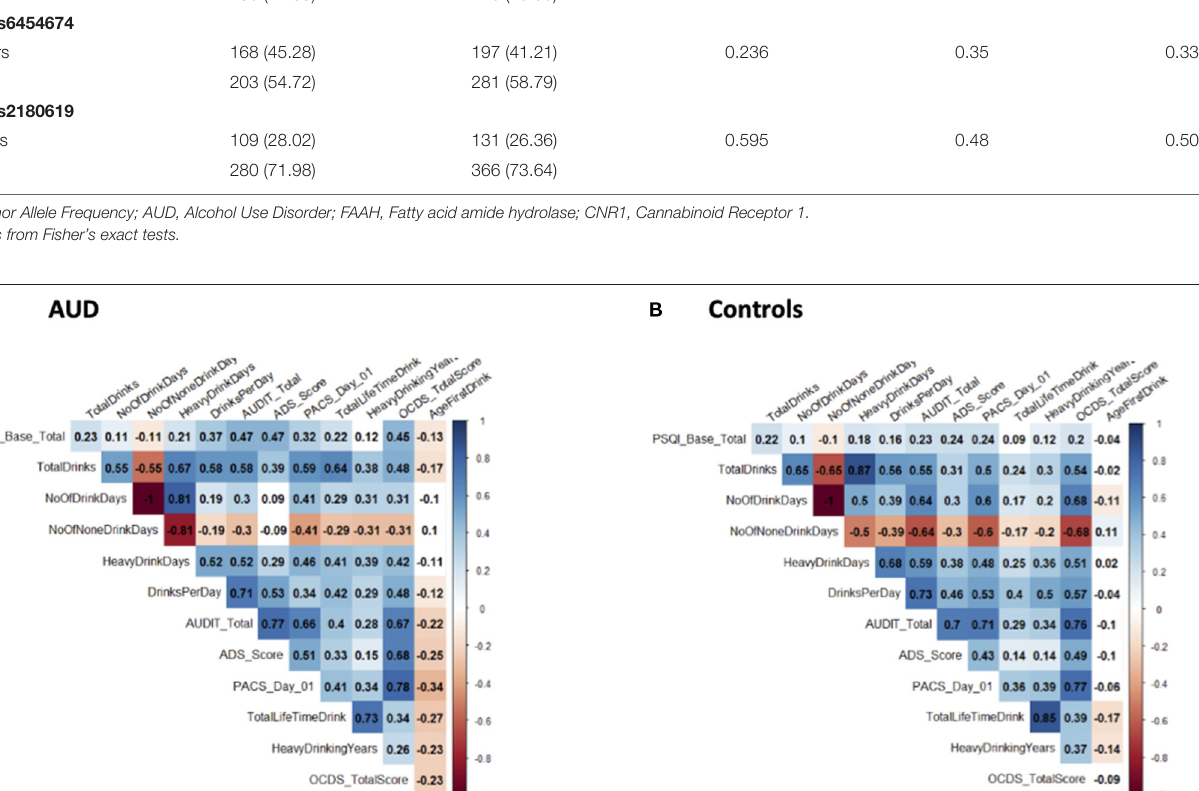
( Figure 2 ). Mean scores (unadjusted and adjusted for covariates) are provided in Supplementary Table 2